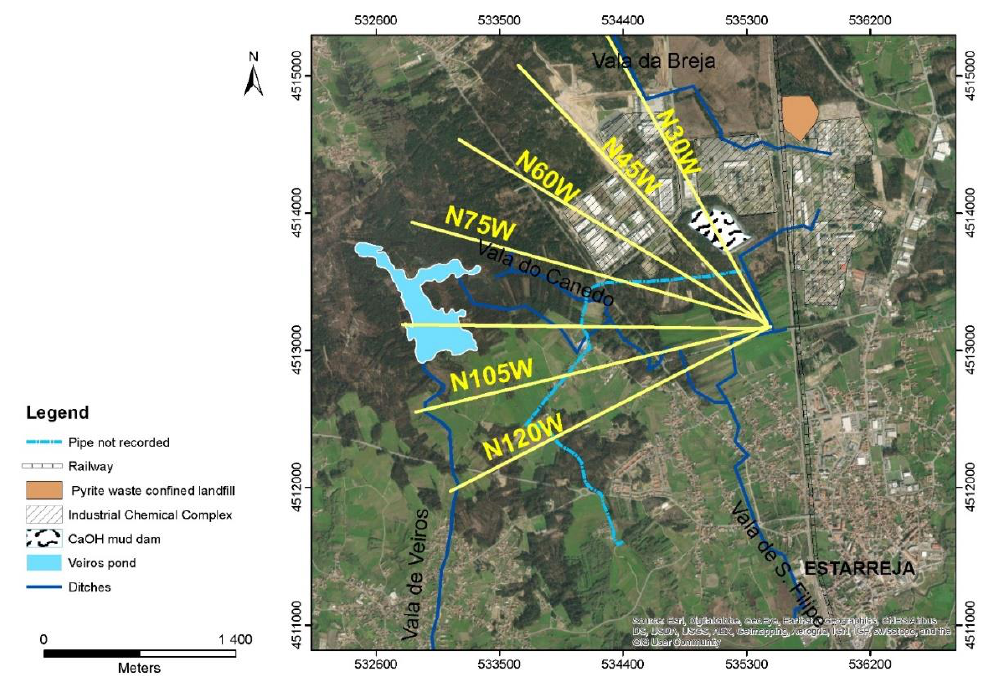
Figure 5. Transects used to sample the shift of the conductivity contouring lines (map coordinates: